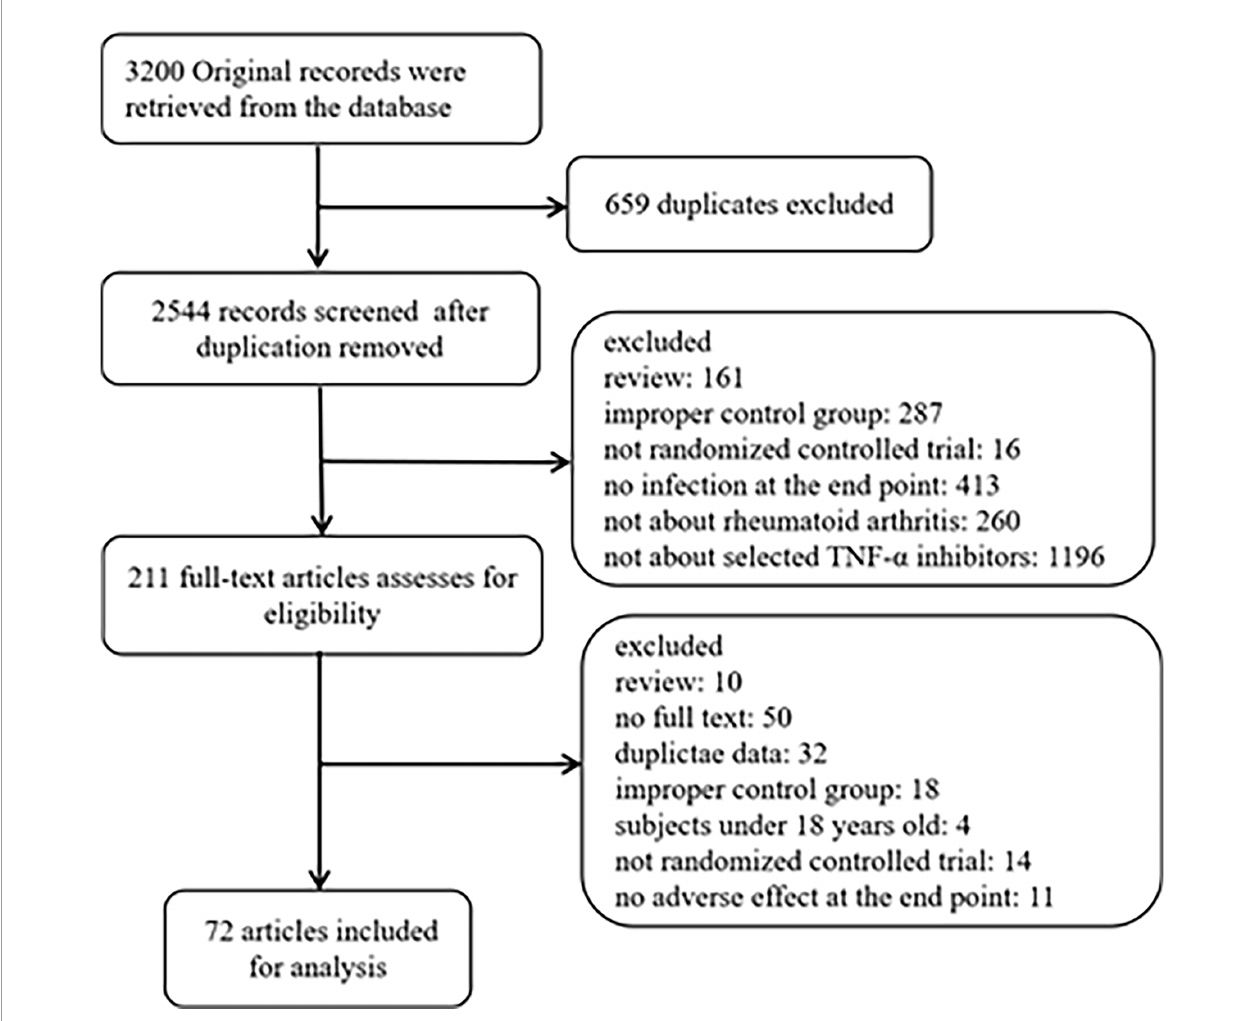
FIGURE 1 | Flow diagram of search